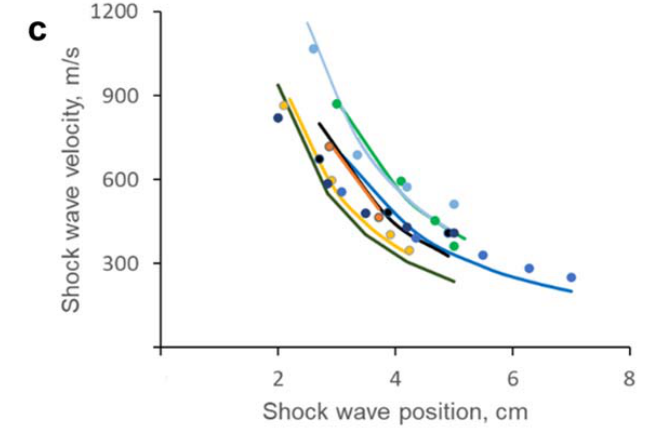
Figure 4. ( a ) Original and ImageJ-enhanced fast-camera captured frames of the explosion video of plasma-treated liquid nitrogen in presence of activated carbon for shock wave imaging. ( b ) Extracted from images above pixel intensity profiles showing position of the shock wave from the center of ex- plosion. ( c ) Measured from the images (markers) and calculated (solid lines) shock wave propagation velocities as a function of the distance from the explosion center for several different